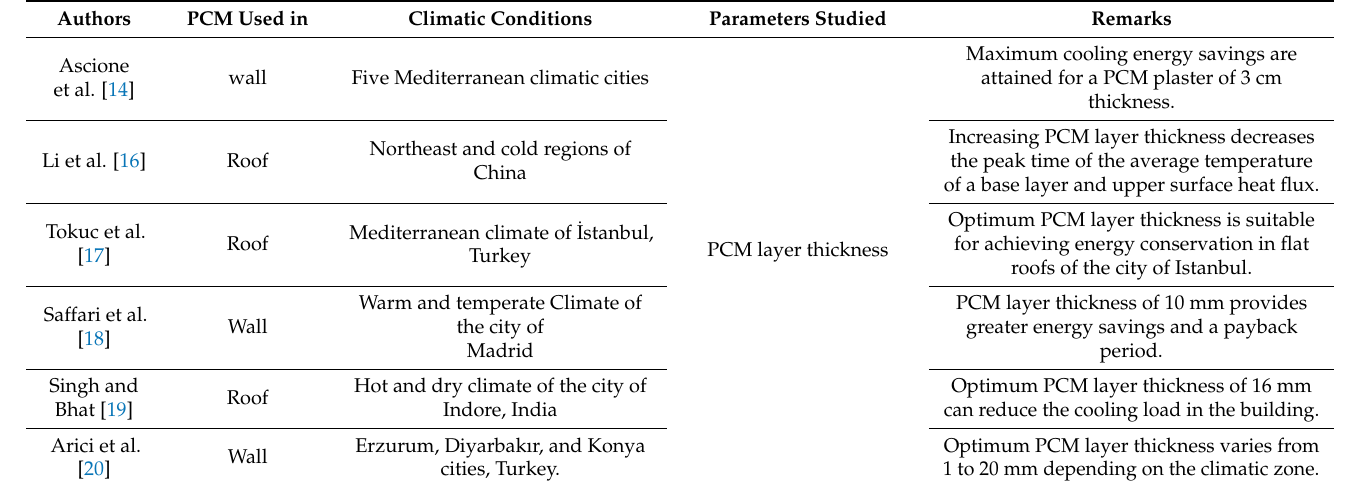
Table 1. Literature